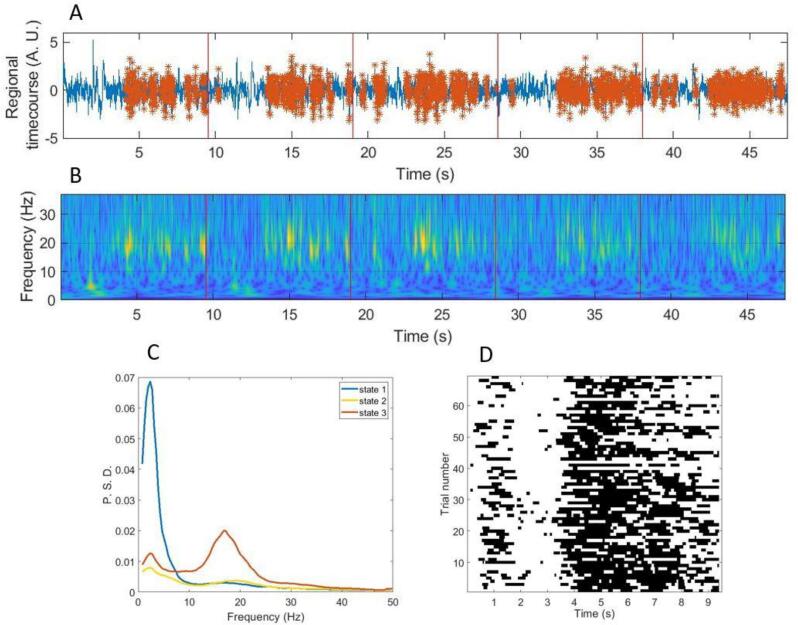
HMM output for a single virtual sensor timeseries, in one representative healthy control participant. A) Broadband (1–48 Hz) regional timecourse data (arbitrary amplitude) with beta burst state identified by the HMM (in red, with trials demarcated with red lines). B) Time-frequency decomposition of the same data generated using a Morlet wavelet transform (trials demarcated in red). C) Spectra showing the component frequencies of the three states identified from the HMM. The state most highly correlated with the beta envelope (the beta burst state 3) is shown in red. D) Raster-plot showing the binarised occurrences of the burst state for all trials, note how the MRBD and PMBR time periods can be easily distinguished. (For interpretation of the references to colour in this figure legend, the reader is referred to the web version of this article.)